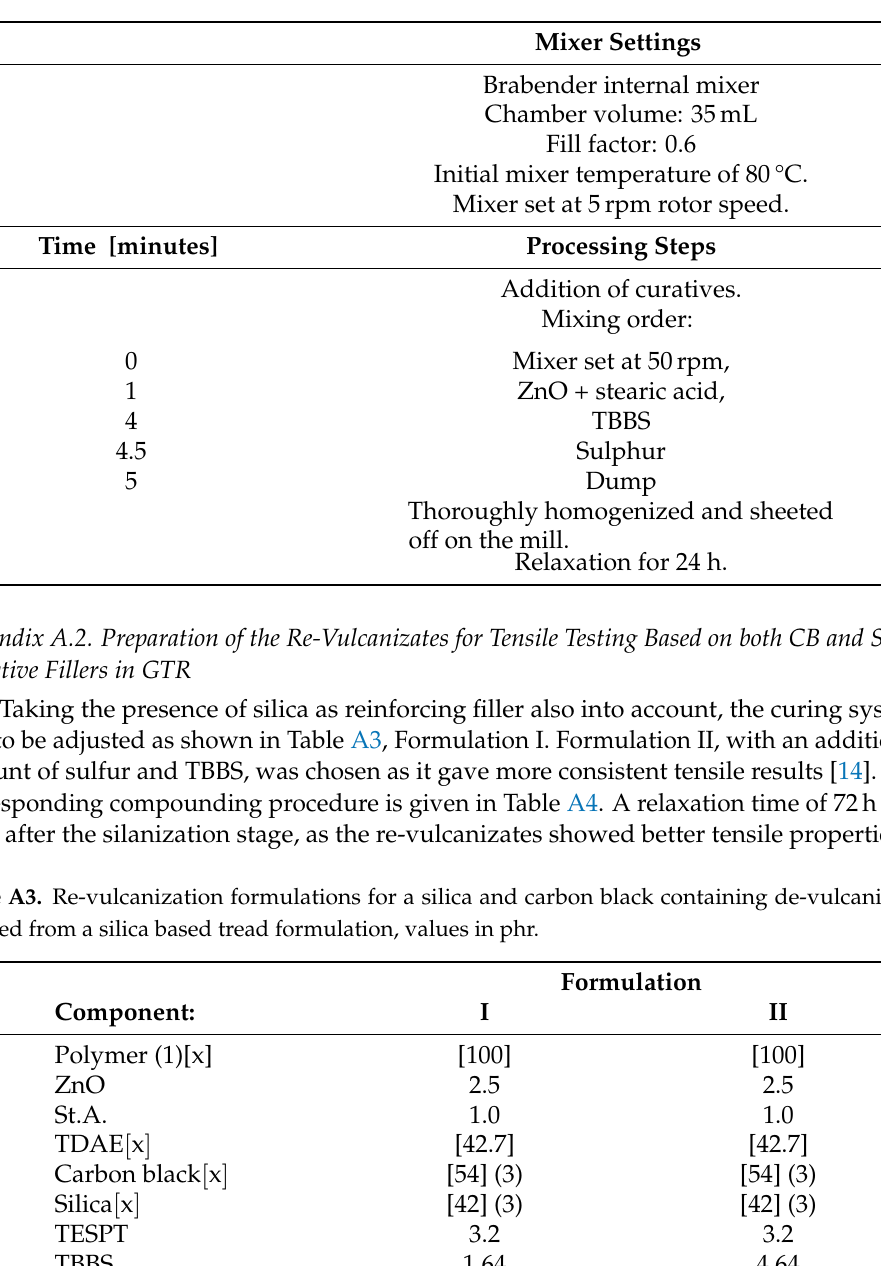
Table A2. Compounding procedure for the carbon black based re-vulcanization formulation as given in Table A1.